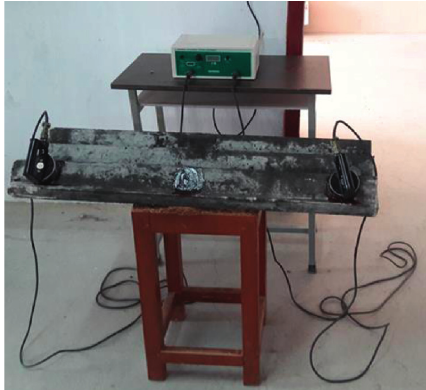
Figure 7: Ultrasonic pulse velocity test.